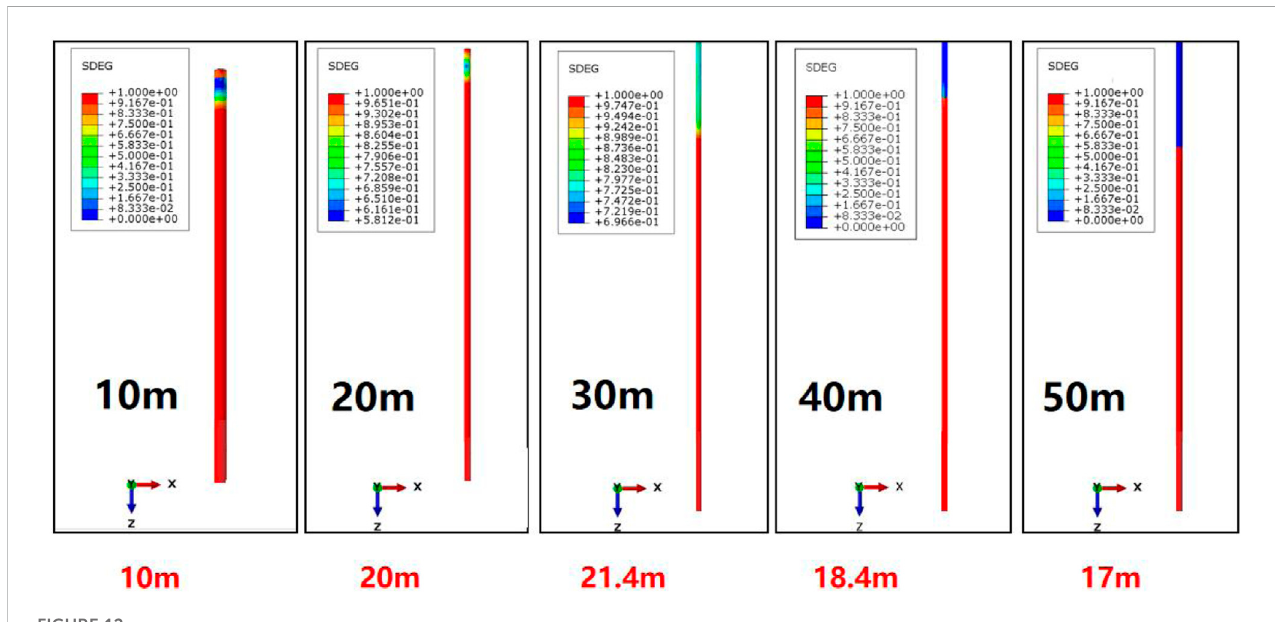
FIGURE 12 The stripping length varies with the length of the cement